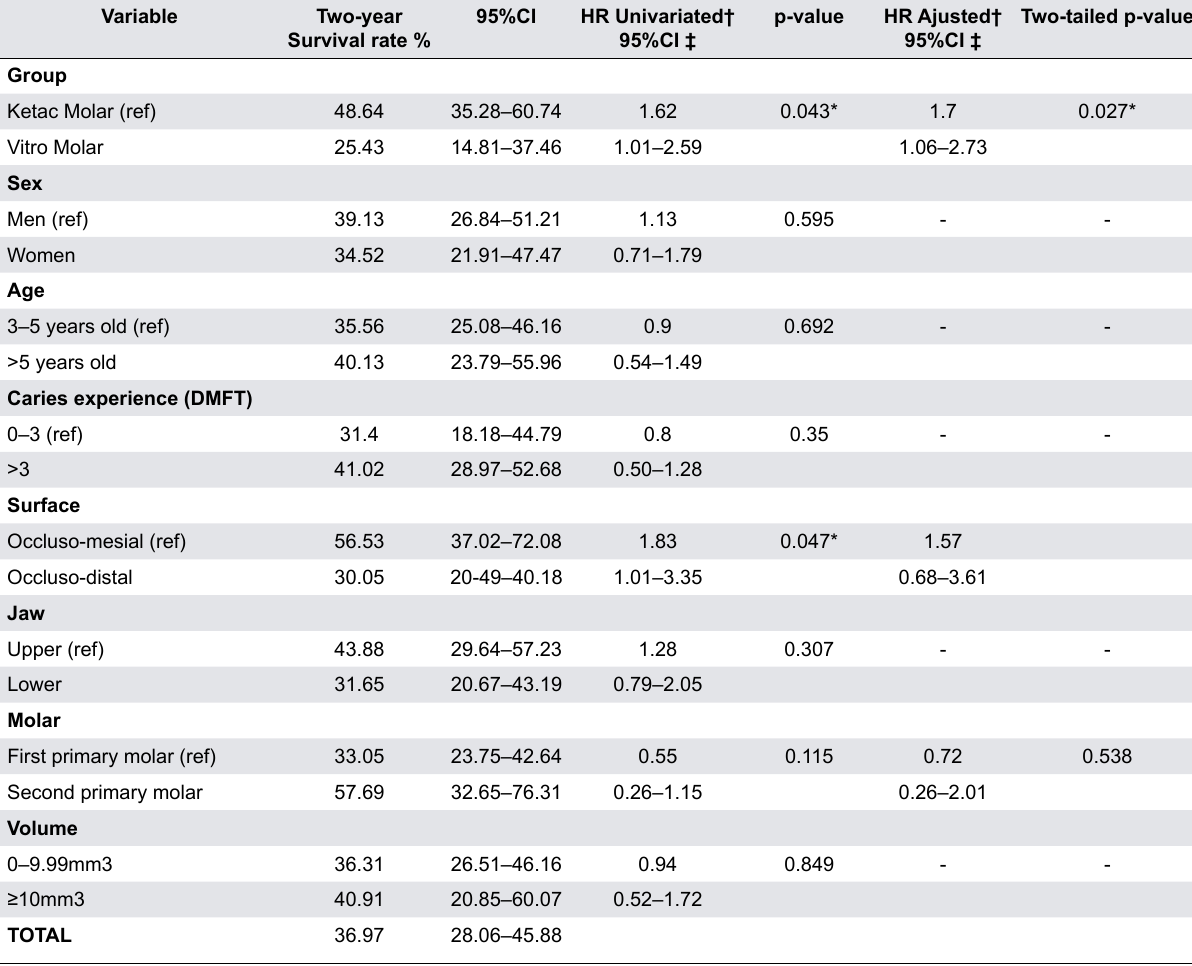
Table 2- Univariate and adjusted Cox Regression analysis for restoration failure between independent variables